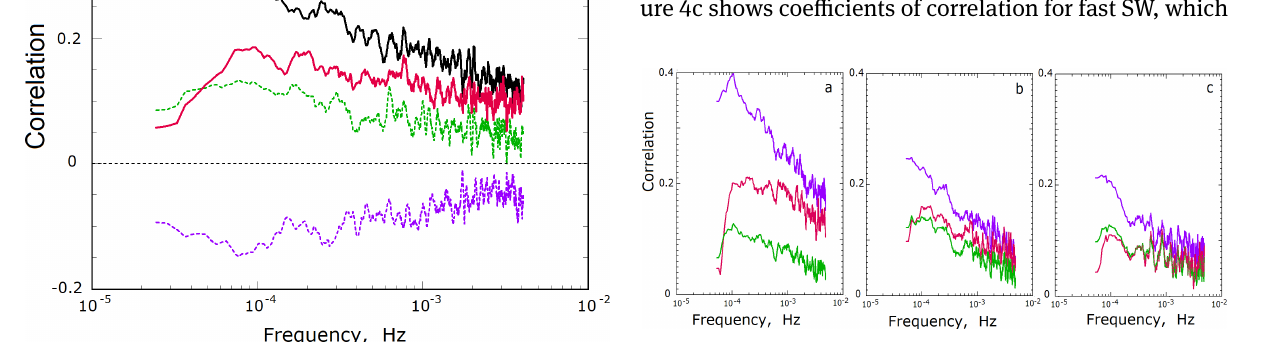
Figure 3. Correlation between radial (R) and normal (N) components of magnetic field ( black solid line ) and velocity ( red solid line ) as functions of frequency, for minima of solar activity. Blue and green dashed lines exhibit cross-correlation of velocity and magnetic fluc- tuations in positive and negative magnetic sectors, correspondently